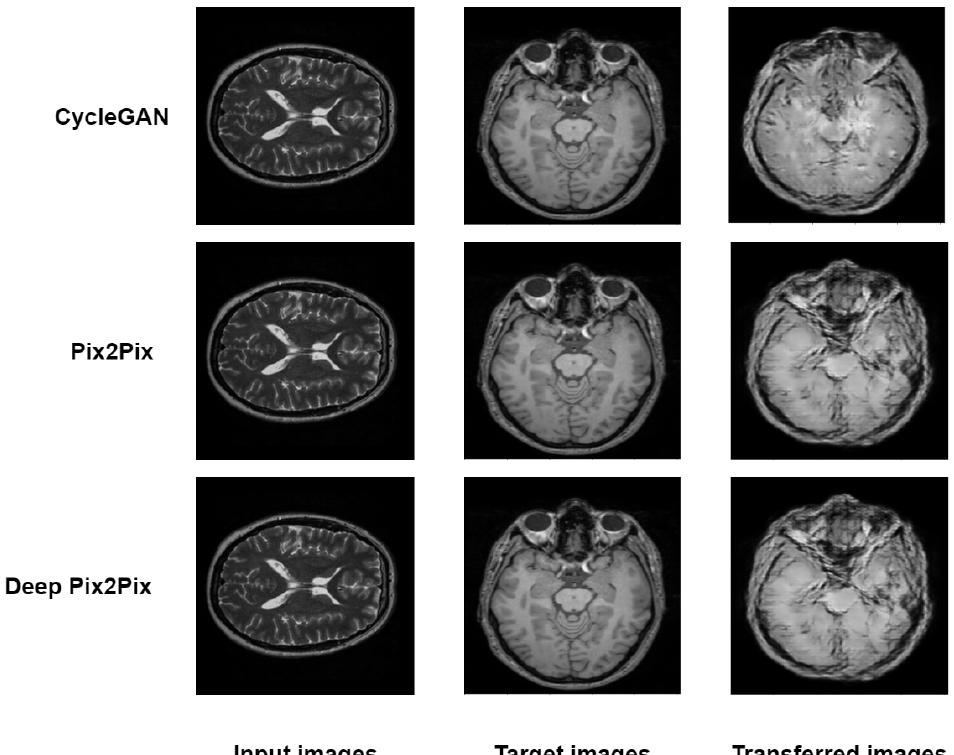
Figure 3. Testing images of CycleGan, Pix2Pix and Deep